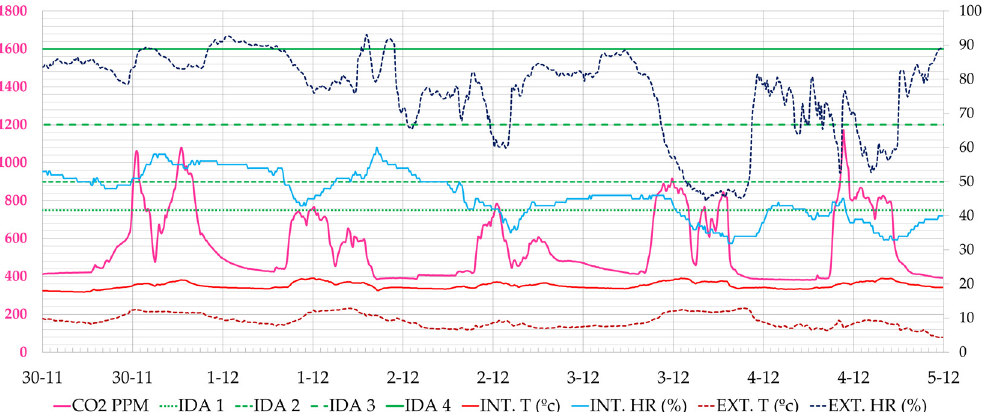
Figure 12. Evolution of CO 2 concentration, interior and exterior temperature and relative humidity in classroom A 2.1, during the week 30 November 2020 to 5 December 2020 (Phase I). Source: authors.